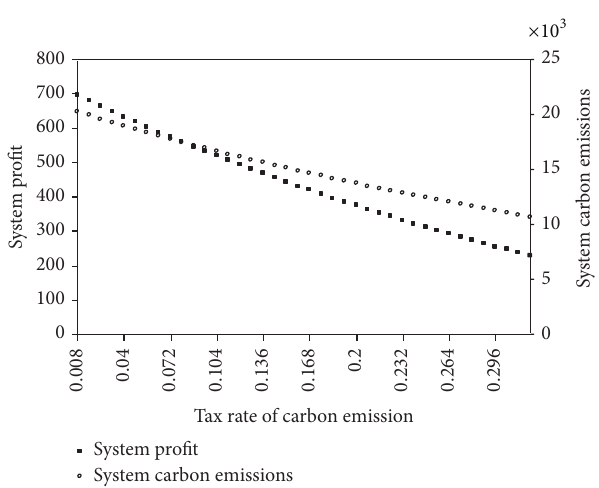
Figure7:Effectofcarbontaxofperunitcarbonemissionsonsupply chain total carbon